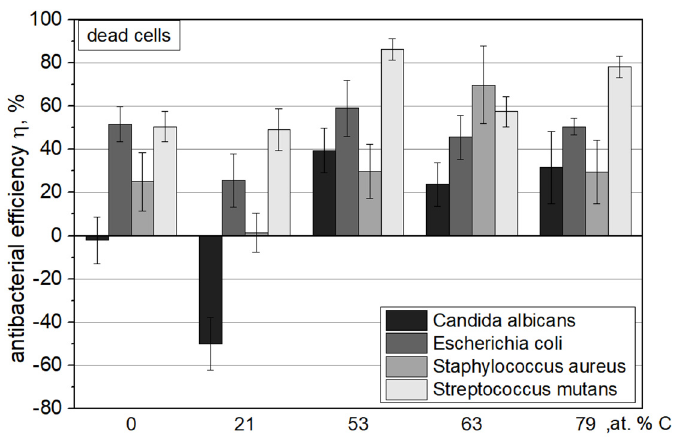
Figure 11. The relative number (cfu/cm 2 ) of dead bacterial cells on the Zr–C coated samples relative to the number of dead bacterial cells on the uncoated 304L sample.